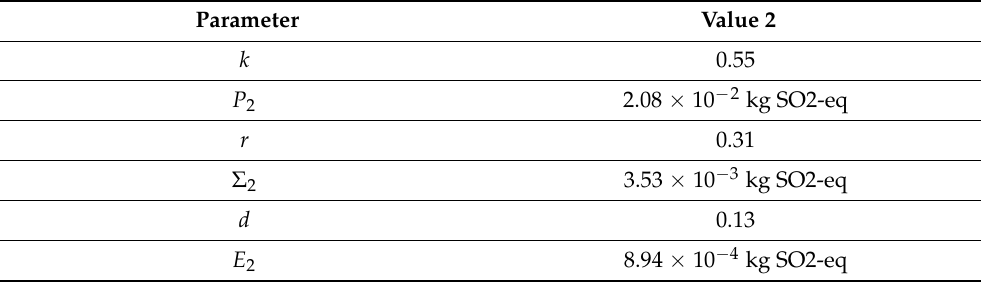
Table 2. Parameter values of the acidification.